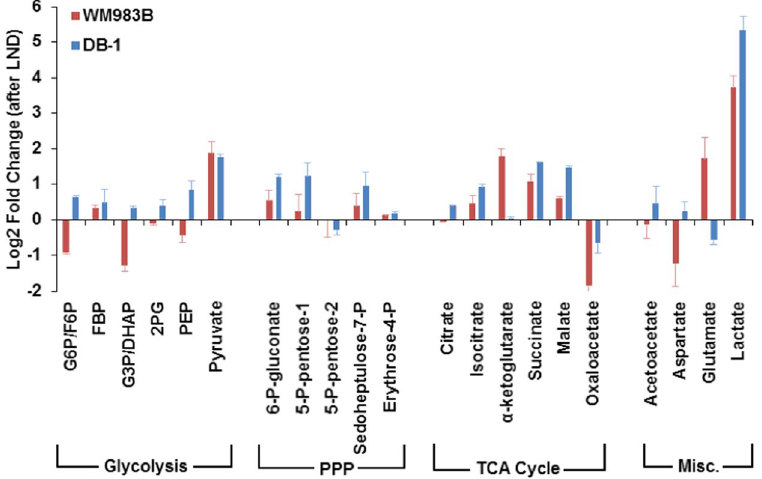
Figure 1. Lonidamine (LND) induces different metabolic responses in WM983B and DB-1 human melanoma cells one hour post treatment. For a given metabolite and cell line, we calculate fold change as the intracellular metabolite amount in the LND group divided by the mean metabolite amount in the CTRL (DMSO sham) group. These fold changes are represented as log base 2. Data shown as mean ± SD.